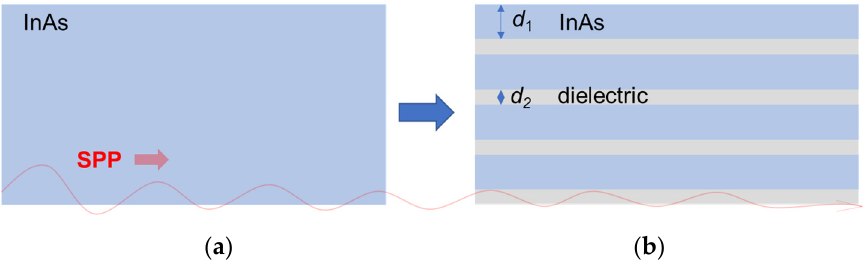
Figure 1. A sketch of the problem under consideration, i.e., propagation of surface plasmon polaritons at the boundary of anisotropic semiconductor ( a ) and hyperbolic metamaterials ( b ) with definitions of the geometrical parameters.